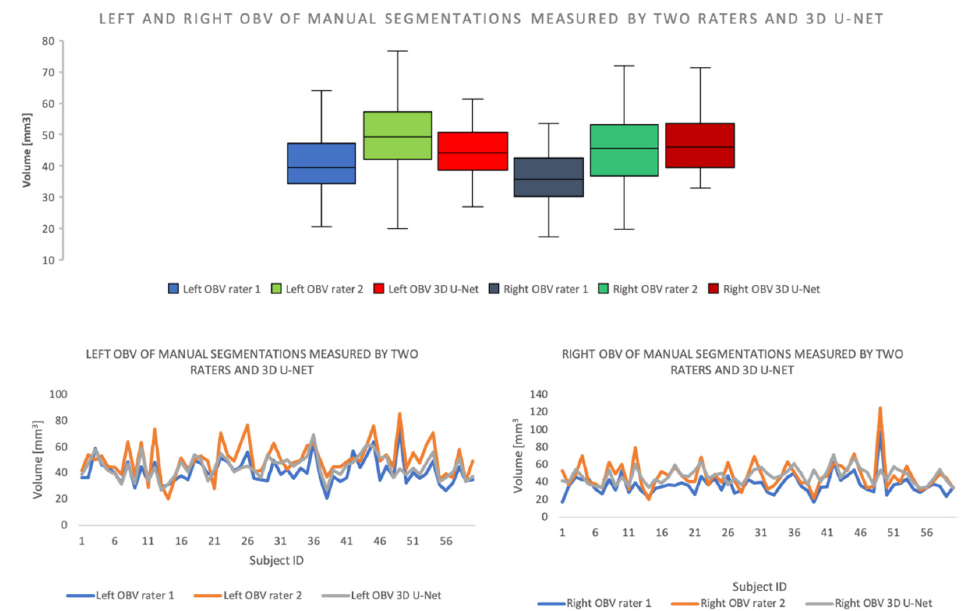
Figure 4. Top : Boxplot showing the OBVs of manual segmentations measured by two independent raters and the 3D U-Net model on test dataset. Bottom left and right : XY-Plot of the left and right OBV measured by two independent raters and 3D U-Net on test dataset. The trend of the graphs shows a high level of congruency of the measurements.